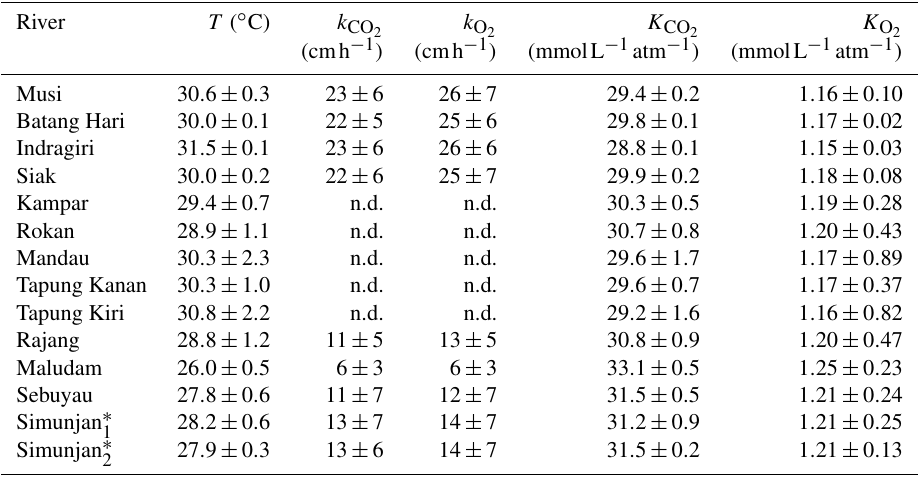
Table A2. Temperature-dependent exchange coefficients k and Henry coefficients K of CO 2 and O 2 for the individual rivers.